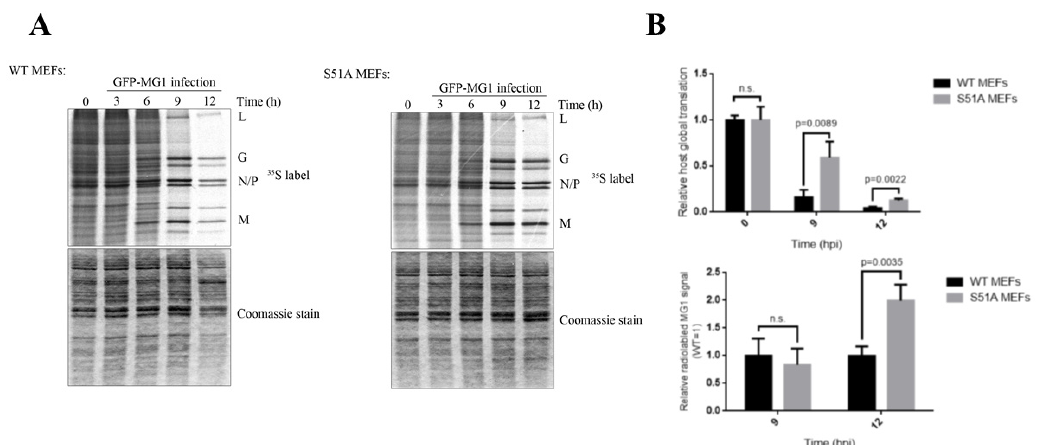
Figure 3. The effect of eIF2 α phosphorylation on the rate of host and MG1 protein synthesis. ( A ) WT and S51A MEFs were infected with MG1 at MOI = 0.1 for the indicated time points and pulse labeled with [ 35 S]-methionine for 20 min. Protein lysate were then separated through 10% SDS-PAGE gel. Coomassie blue stain was used as loading control. ( B ) Top: Densitometry of the relative radioactive signal of the area between the viral L and G bands was normalized to the entire related lane on Coomassie gel at 0, 9 and 12 hpi to determine the rate of host global translation. Bottom: the relative radioactive signal from the viral M protein to Coomassie stain was normalized to the signals from the WT MEFs at each time points to measure the rate of viral translation between the two cell lines.